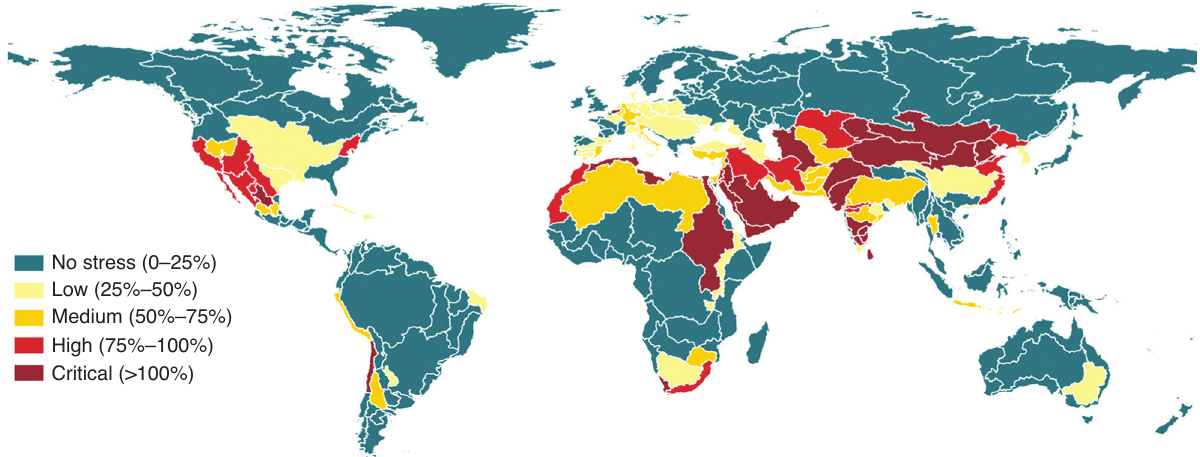
Figure 8 SDG 6.4.2 – Level of water stress, by major river basin expressed in percentages. Reference year 2018. Geographic projection.